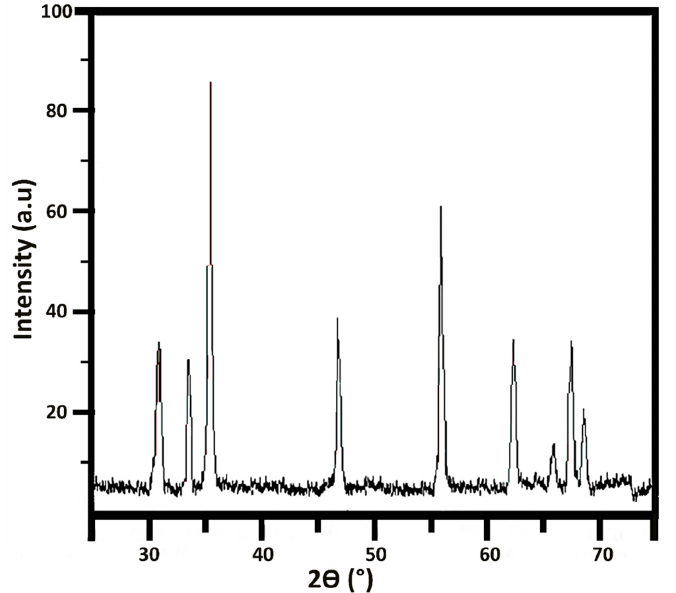
Figure 6. X-ray diffraction of the ZnO nanorods.